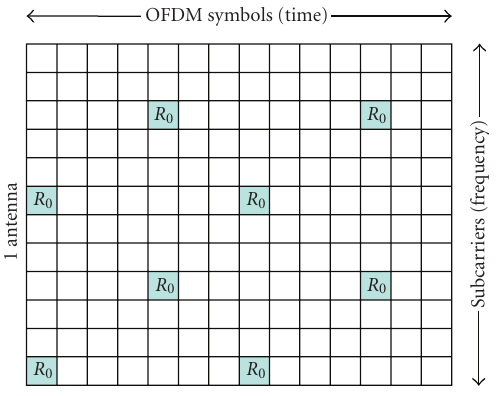
Figure 4: Reference pilots in LTE.